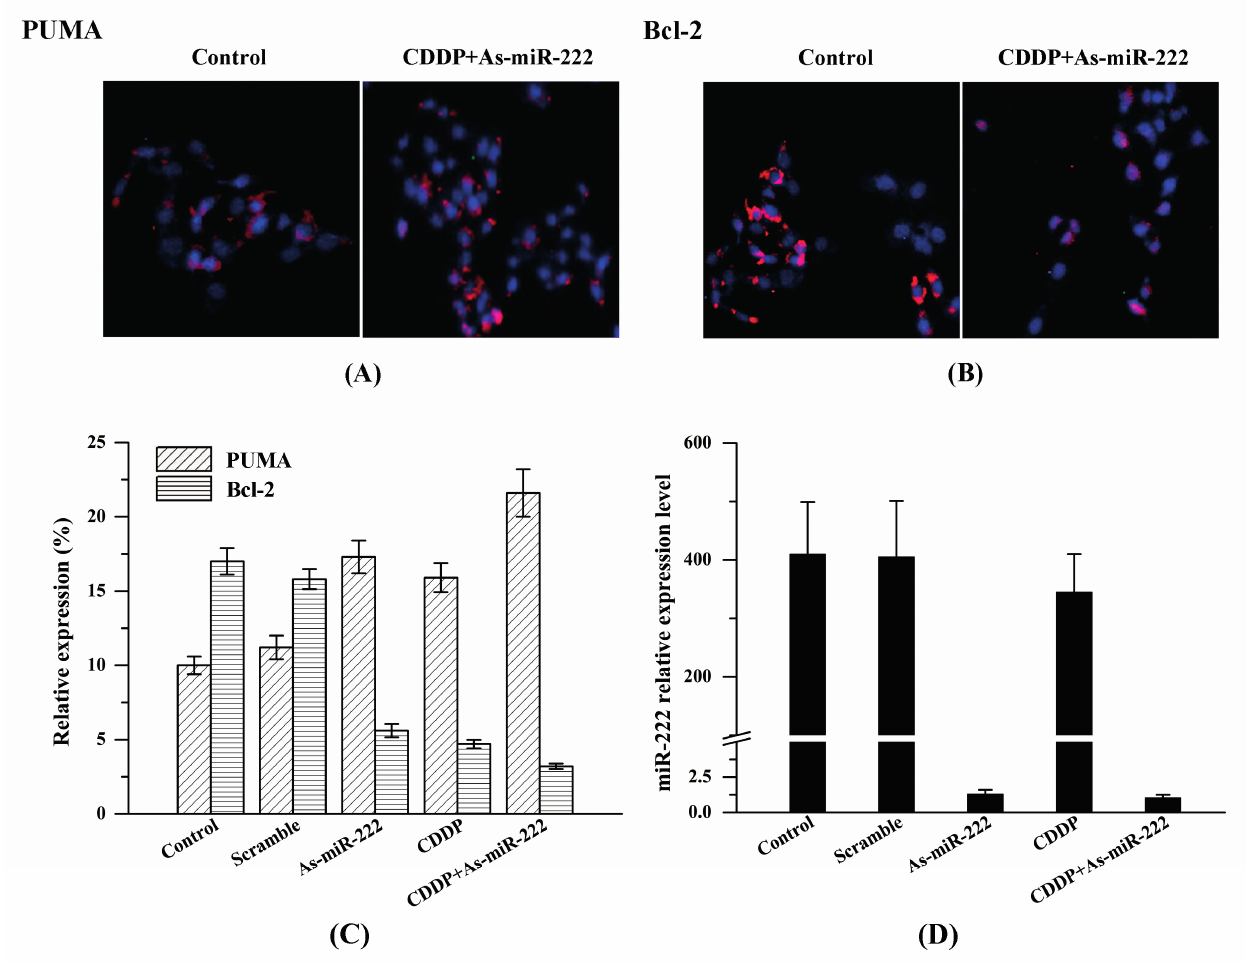
Figure 3. Determination of the expression of PUMA and Bcl-2 in UM1 cells with treatment of As-miR-222 and CDDP by immunofluorescence confocal microscopy; ( A ) Images showed that PUMA was overexpressed with treatment of As-miR-222 and CDDP in UM1 cells; ( B ) The expression of Bcl-2 exhibited an opposite trend compared with PUMA expression; ( C ) Relative expression of PUMA and Bcl-2; ( D ) miR-222 expression as control, detected by